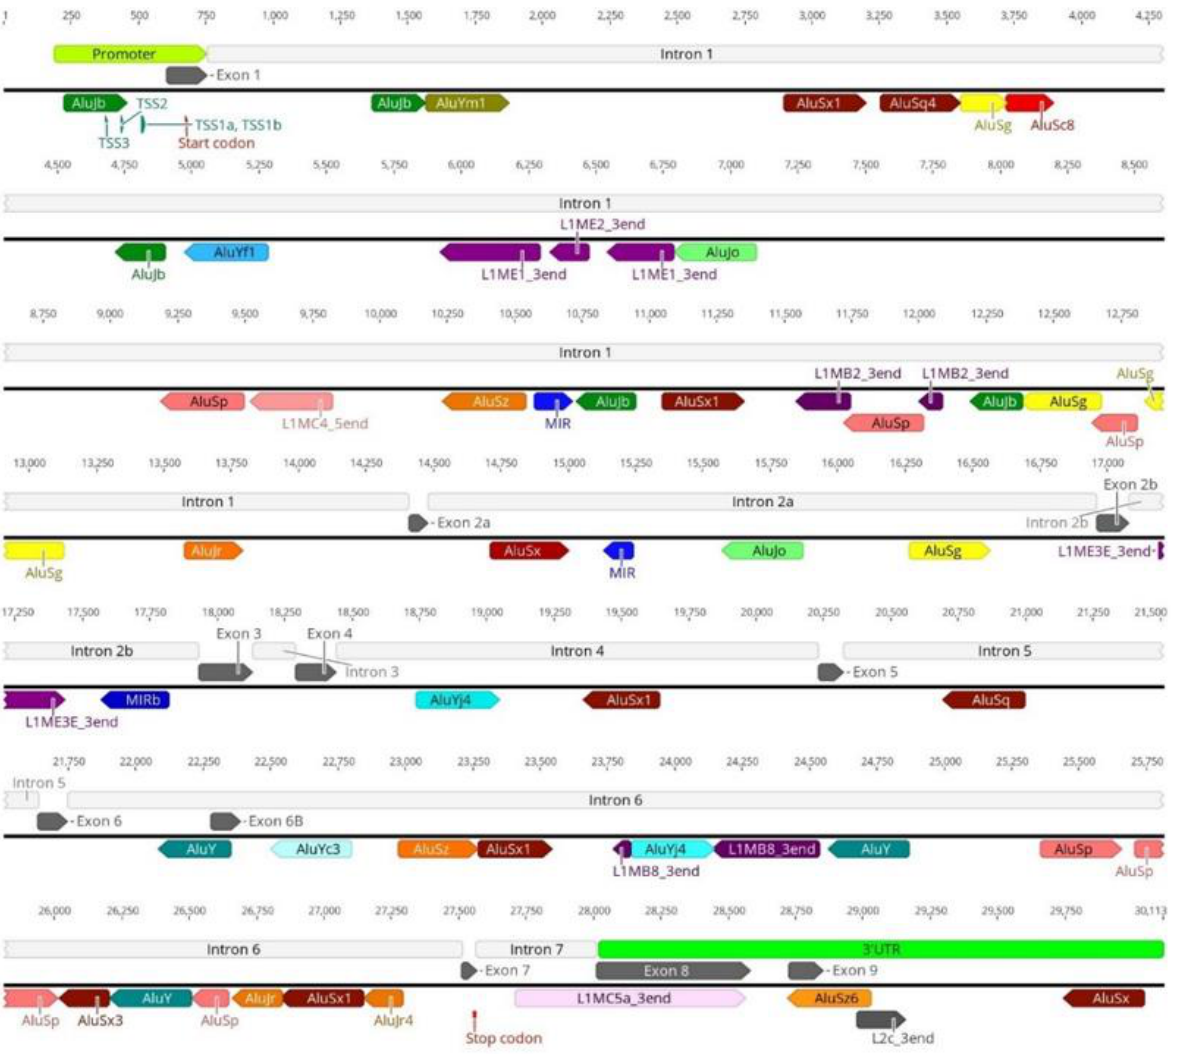
Figure 6. Identification of TEs within the reference SMN1 / 2 gene sequence. SMN1 / 2 exons are represented by grey arrows and introns by white boxes. SMN1 / 2 promoter is represented by a green box and other regulatory motifs by green arrows. Start and stop codons are represented by small red arrows. Transposable elements position and orientation is indicated by colored arrows, with the direction of the arrow indicating the orientation of the repeat element.